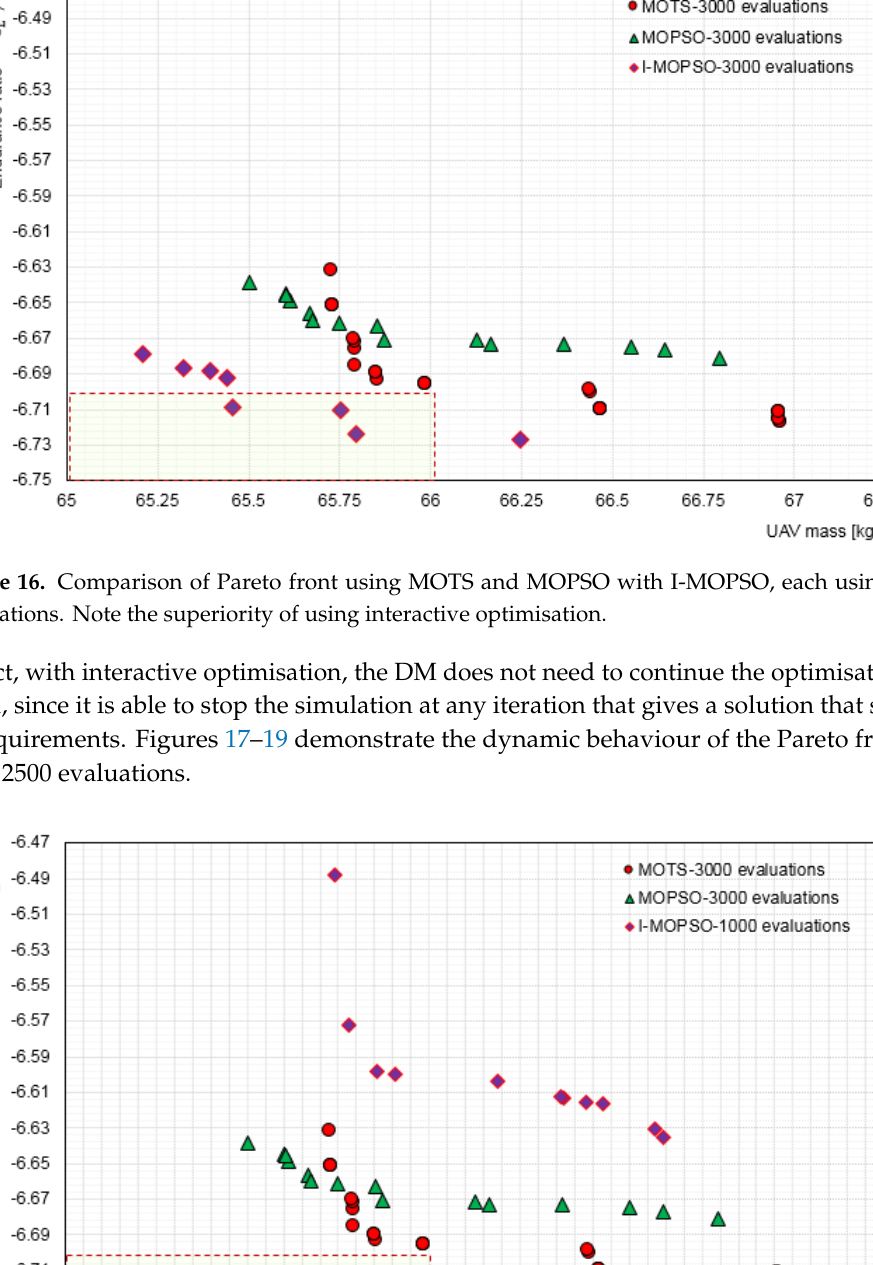
19 of 32 Figure 15. Comparison of Pareto front for MOTS and MOPSO using 5500 evaluations, and with I-MOPSO using 3000 evaluations. An additional demonstration of the superiority of undertaking optimisation interactively is